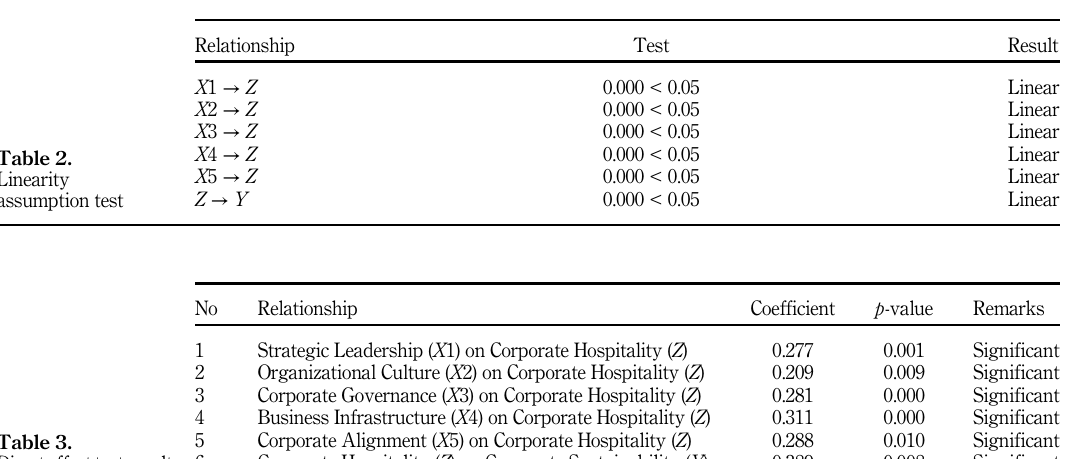
Table 3. Directeffecttestresults